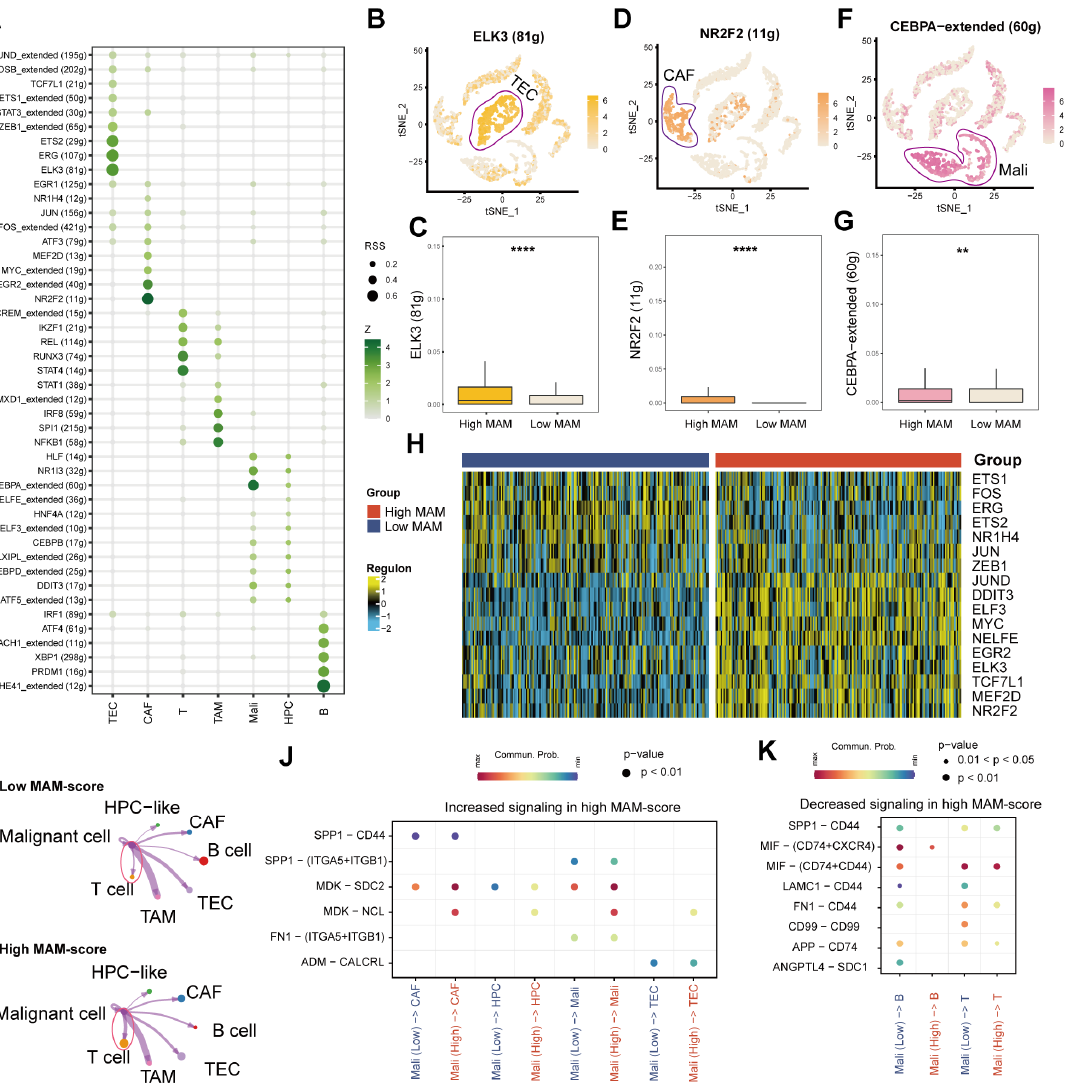
Figure 5. Identification of the mechanisms underlying MAM. ( A ): Activity of TFs of different cell types. ( B – G ): Boxplots comparing ELK3 (81 g), NR2F2 (11 g), and CEBPA-extended (60 g)